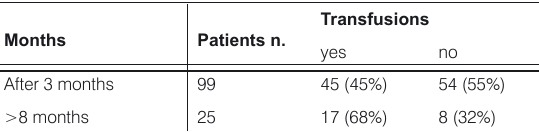
Table 7. Chemotherapy duration and frequency of